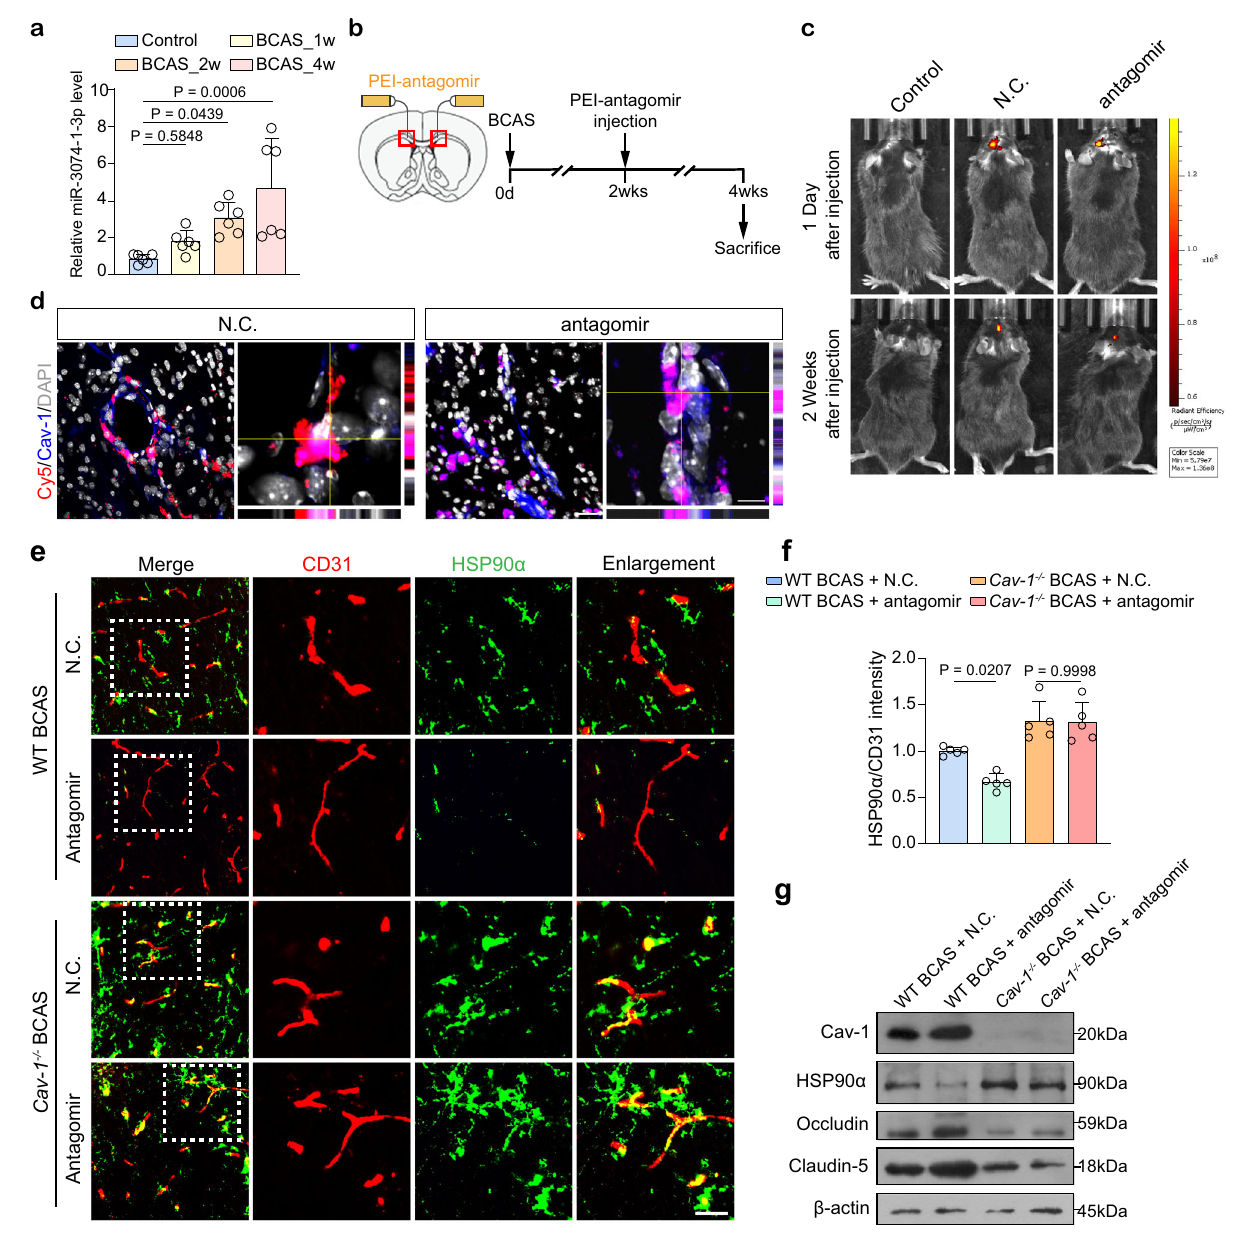
Fig. 9 | TheendothelialCav-1and HSP90 α levelafter miR-3074-1-3p antagomir treatmentinmiceof2genotypes.a LevelsofmiR-3074-1-3pintheCCatdifferent time points after BCAS ( n =6 mice/group). b Experimental fl ow chart. c In vivo fl uorescenceimages showing the fl uorescent signal of N.C. or antagomir delivered in the CC 1 day and 2 weeks following BCAS ( n =5 mice/group). d Representative orthogonal images with x-y , x-z , and y-z views showing the uptake of Cy5-labeled